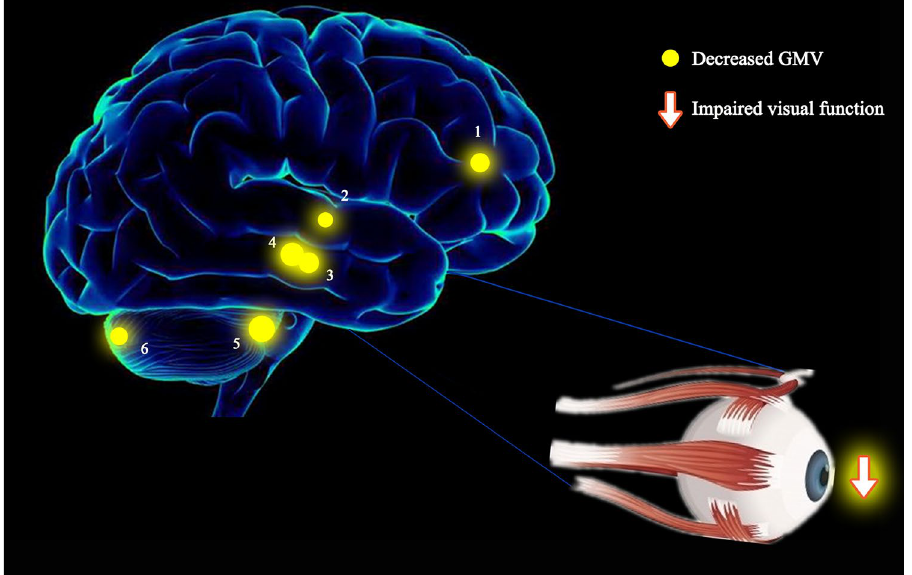
Figure 4. The GMV results of brain activity in the SA group. Compared with the HCs, the GMV of SA patients in the following regions were decreased to various extents: 1-left anterior cingulate (t = − 5.596), 2-right superior temporal gyrus (t = − 5.330), 3-right parahippocampal gyrus (t = − 5.683), 4-left parahippocampal gyrus (t = − 6.553), 5-right anterior lobe of cerebellum (t = − 7.345), 6-right posterior lobe of cerebellum (t = − 5.451). Notes : The sizes of the spots denote the degree of quantitative changes. GMV gray matter volume, SA strabismus with amblyopia, HC healthy